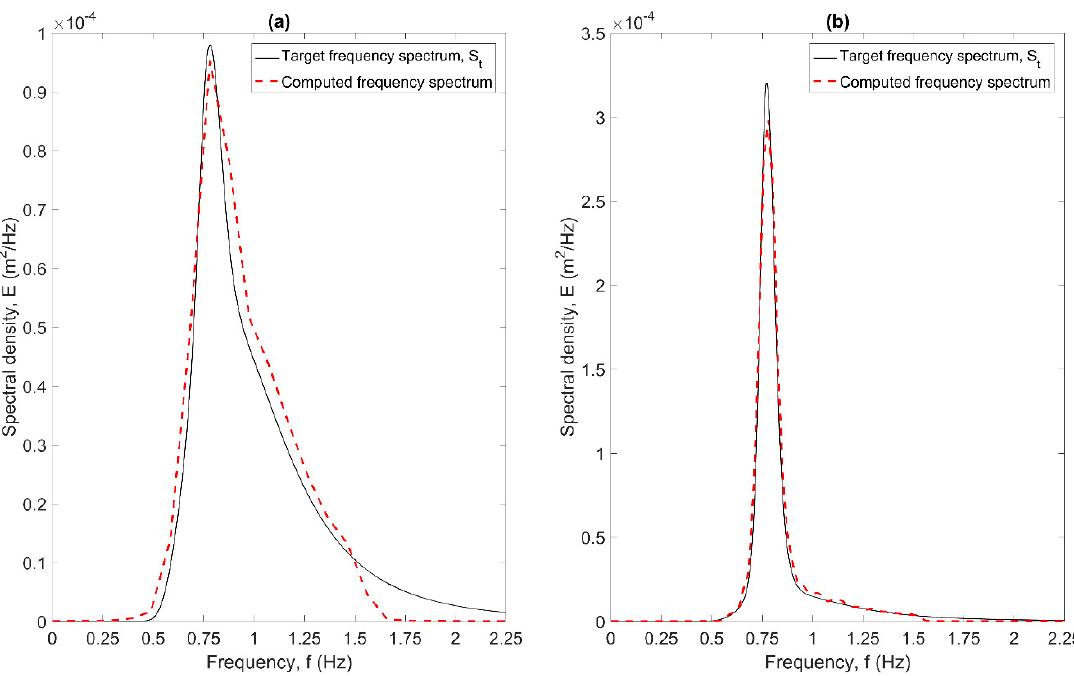
Figure 13. Comparison between the frequency spectra simulated in MILDwave and the target frequency spectrum for irregular waves with H s = 2.54 cm, T p = 1.3 s, σ θ = 0 ◦ , and ( a ) γ = 2 and ( b ) γ = 20.